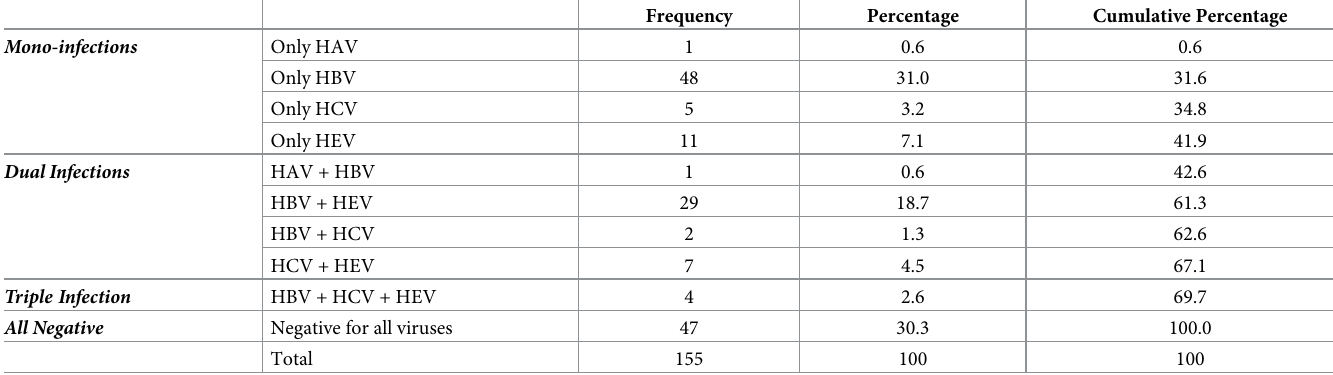
Table 4. Frequency table of mono and